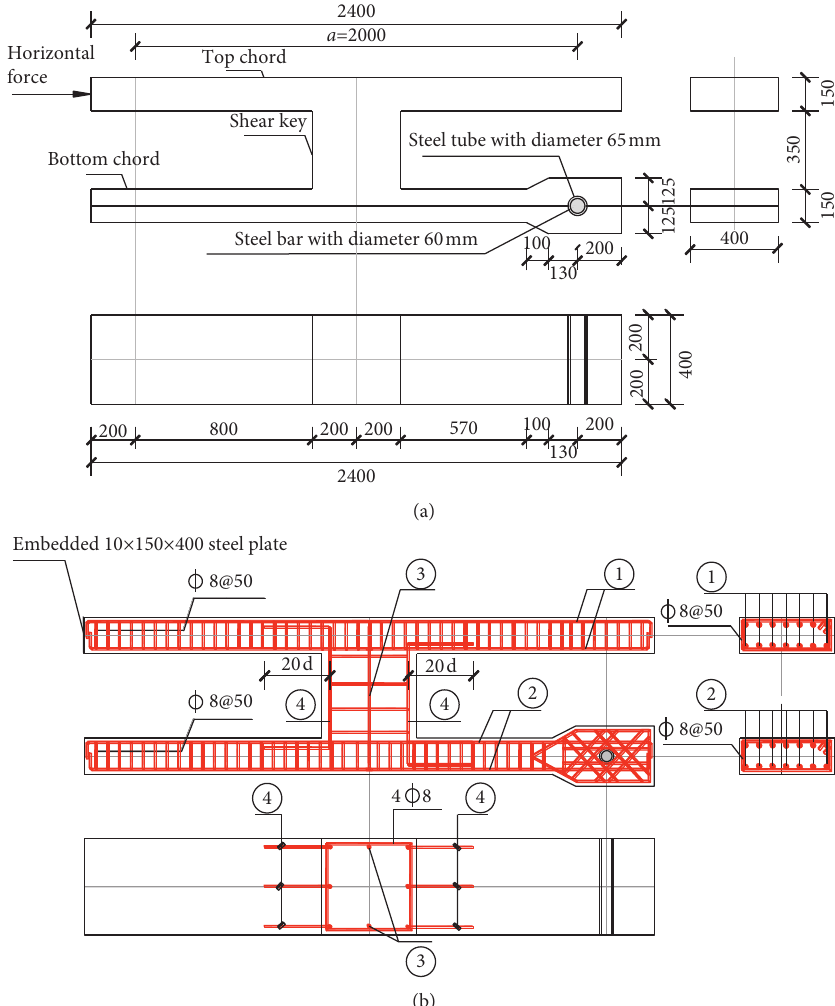
Figure 4: (a) Size diagram and (b) reinforcement arrangement diagram of test pieces.